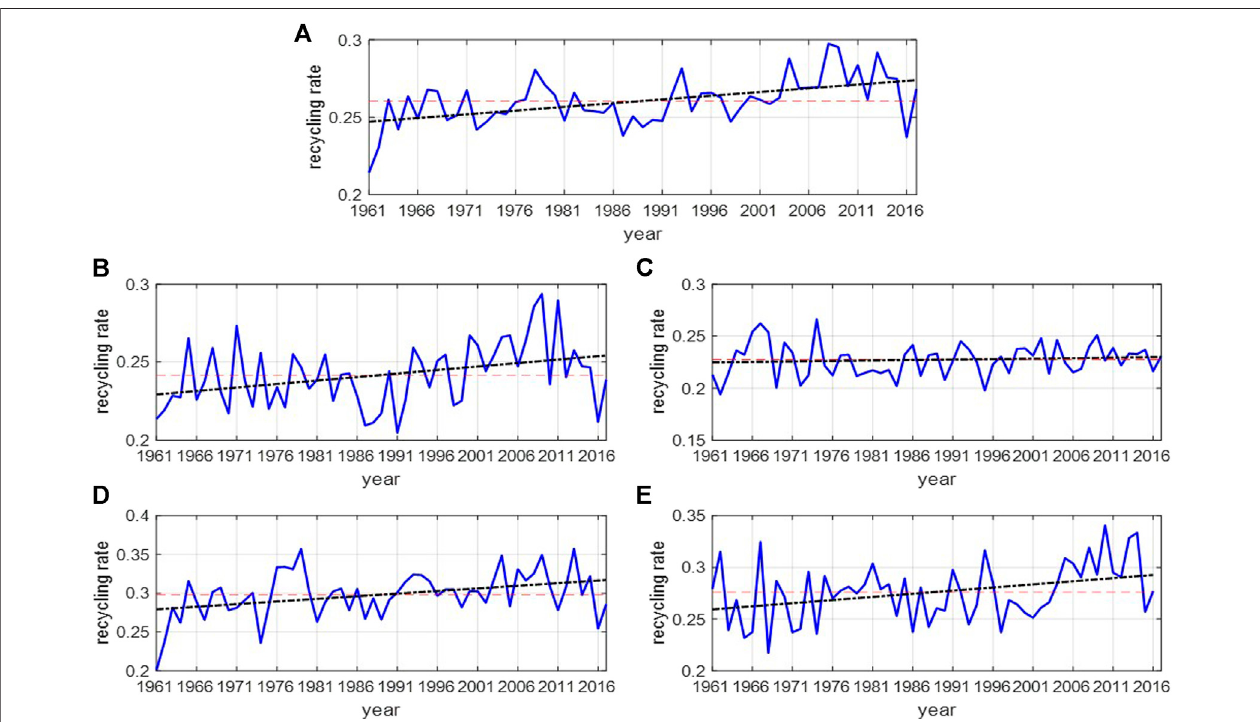
TABLE 1 | Correlation coef fi cients between the seasonal PRR in the MLRYR and the input of water vapor through each boundary and local